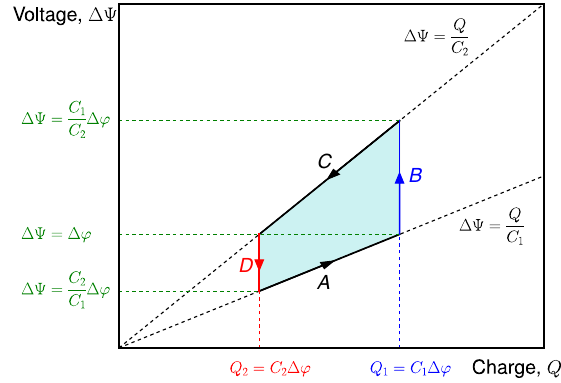
FIG. 6. Capacitive mixing thermodynamic cycle, using two electrolytes with different salt concentrations. Segment A: the electrochemical cell is charged under a supply voltage Δ φ in the presence of the more concentrated electrolyte (sea water), corresponding to a large cell capacitance C 1 . Segment B: the voltage between the electrodes rises when the electrolyte is replaced by the more dilute one (river water, small cell capaci- tance C 2 ) under open circuit conditions. Segment C: the electro- chemical cell is then discharged down to the supply voltage Δ φ , before being flushed with a concentrated electrolyte under open circuit conditions (segment D). The energy extracted per cycle, Δ E , is equal to the area of the shaded region. cycle